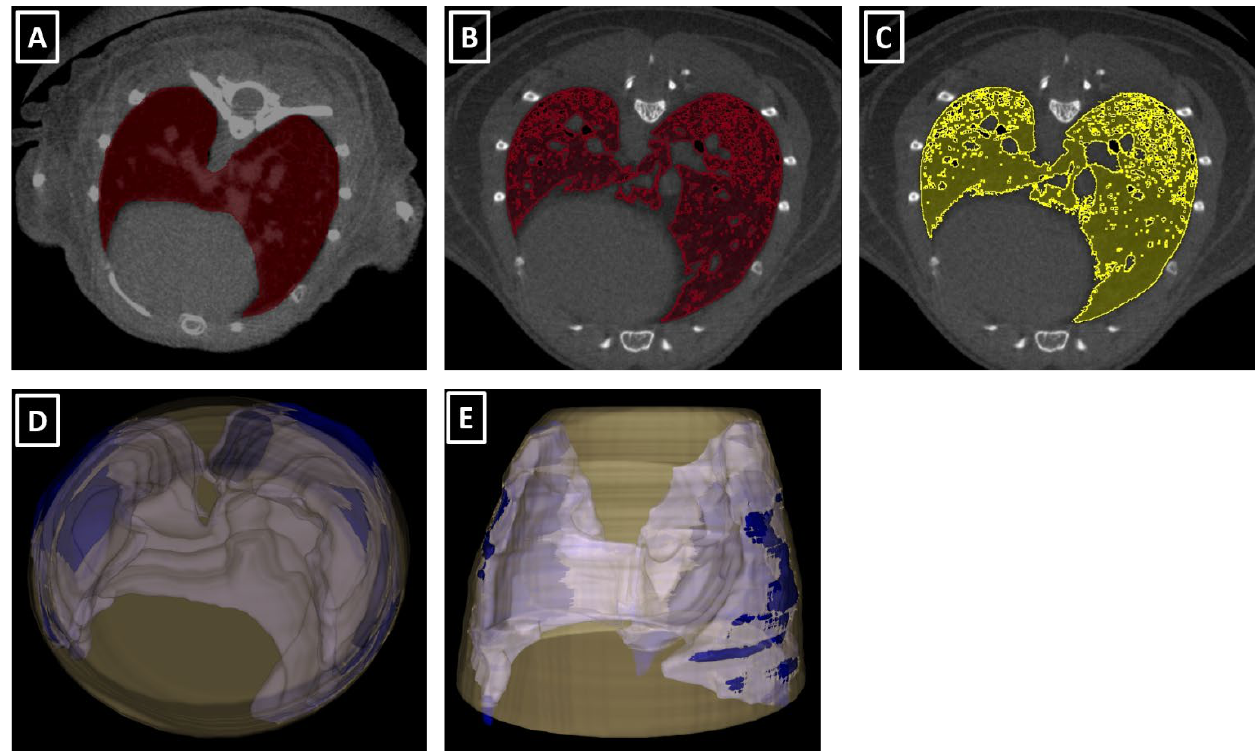
Figure 2. Manually delineated and thresholded lung volume segmentations. ( A ) Manual delineation of lung volume, with ROI (red) covering the lung overlaid on transversal µCT image of the lung. Note the inclusion of intrapulmonary soft tissue. ( B ) Thresholded segmentation of aerated lung tissue (red ROI) applying a − 700/ − 400 Hounsfield Units threshold. ( C ) Thresholded segmentation of aerated lung tissue (yellow ROI) with − 700/ − 300 Hounsfield Units threshold. Note the different lung tissue inclusion in the segmentation between ( B ) and ( C ), depending on the applied threshold. ( D , E ) Three-dimensional rendering of the manually delineated segmentation (blue) and the thoracic volume superimposed (yellow). The inclusion of structures such as the heart in the thoracic volume is visually evident.